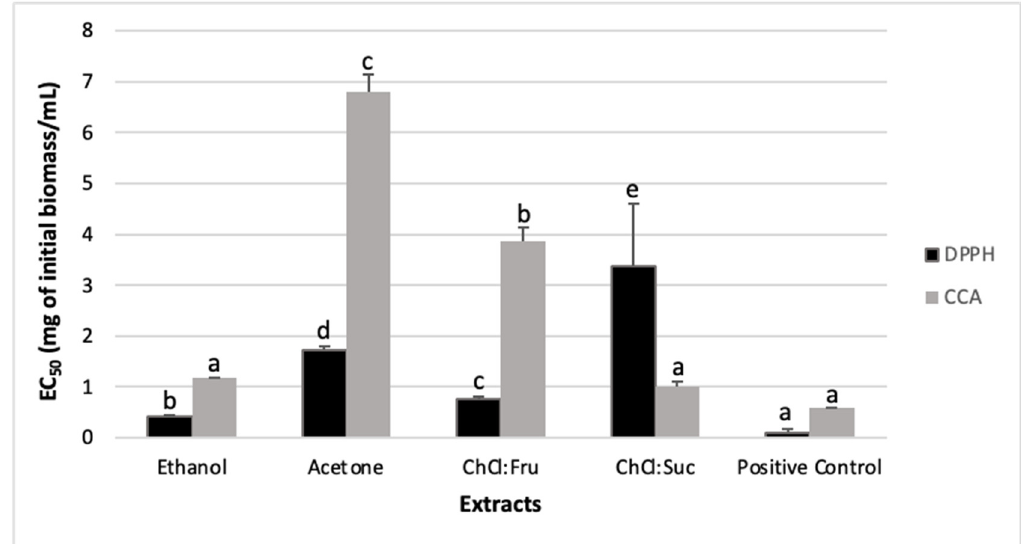
Figure 1. Radical scavenging activity (RSA) on 2,2-diphenyl-1-picrylhydrazyl (DPPH) and copper chelating activity (CCA), expressed as EC 50 values (mg of initial biomass per mL) of the extracts from Polygonum maritimum L. (sea knotgrass). Results are presented as mean values ± standard error (SE) of at least six replicates (n = 6). Columns with different letters are significantly different at p < 0.05 (Duncan’s new multiple range test). Positive control for DPPH: BHT (butylated hydroxytoluene); positive control for CCA: EDTA (ethylenediaminetetraacetic acid).